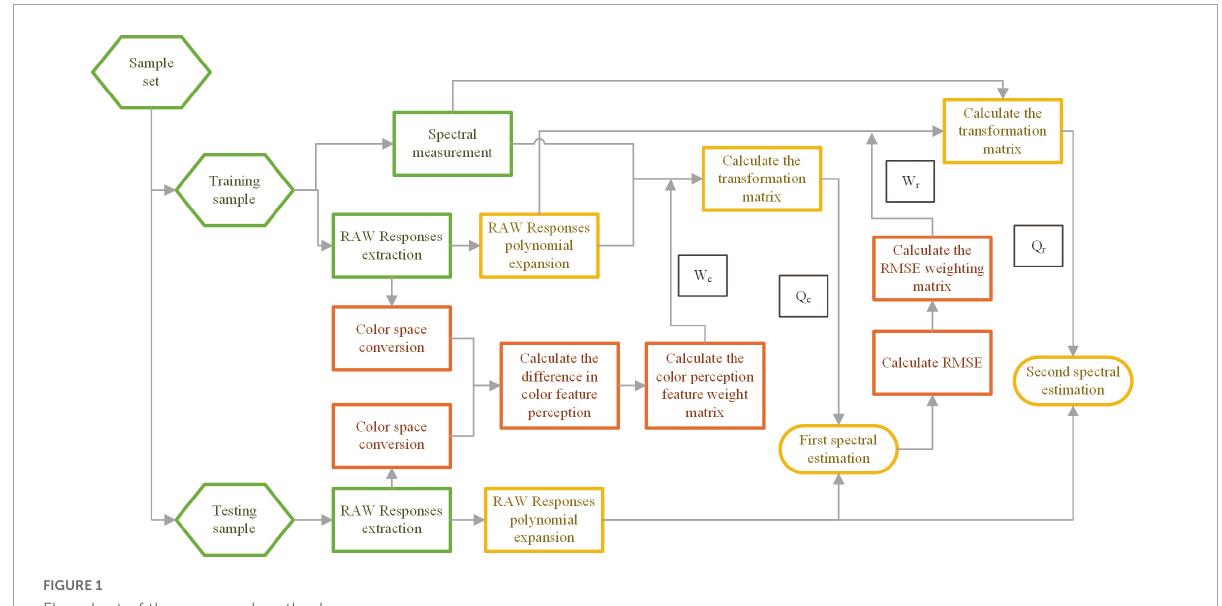
FIGURE1 Flowchart of the proposed method.